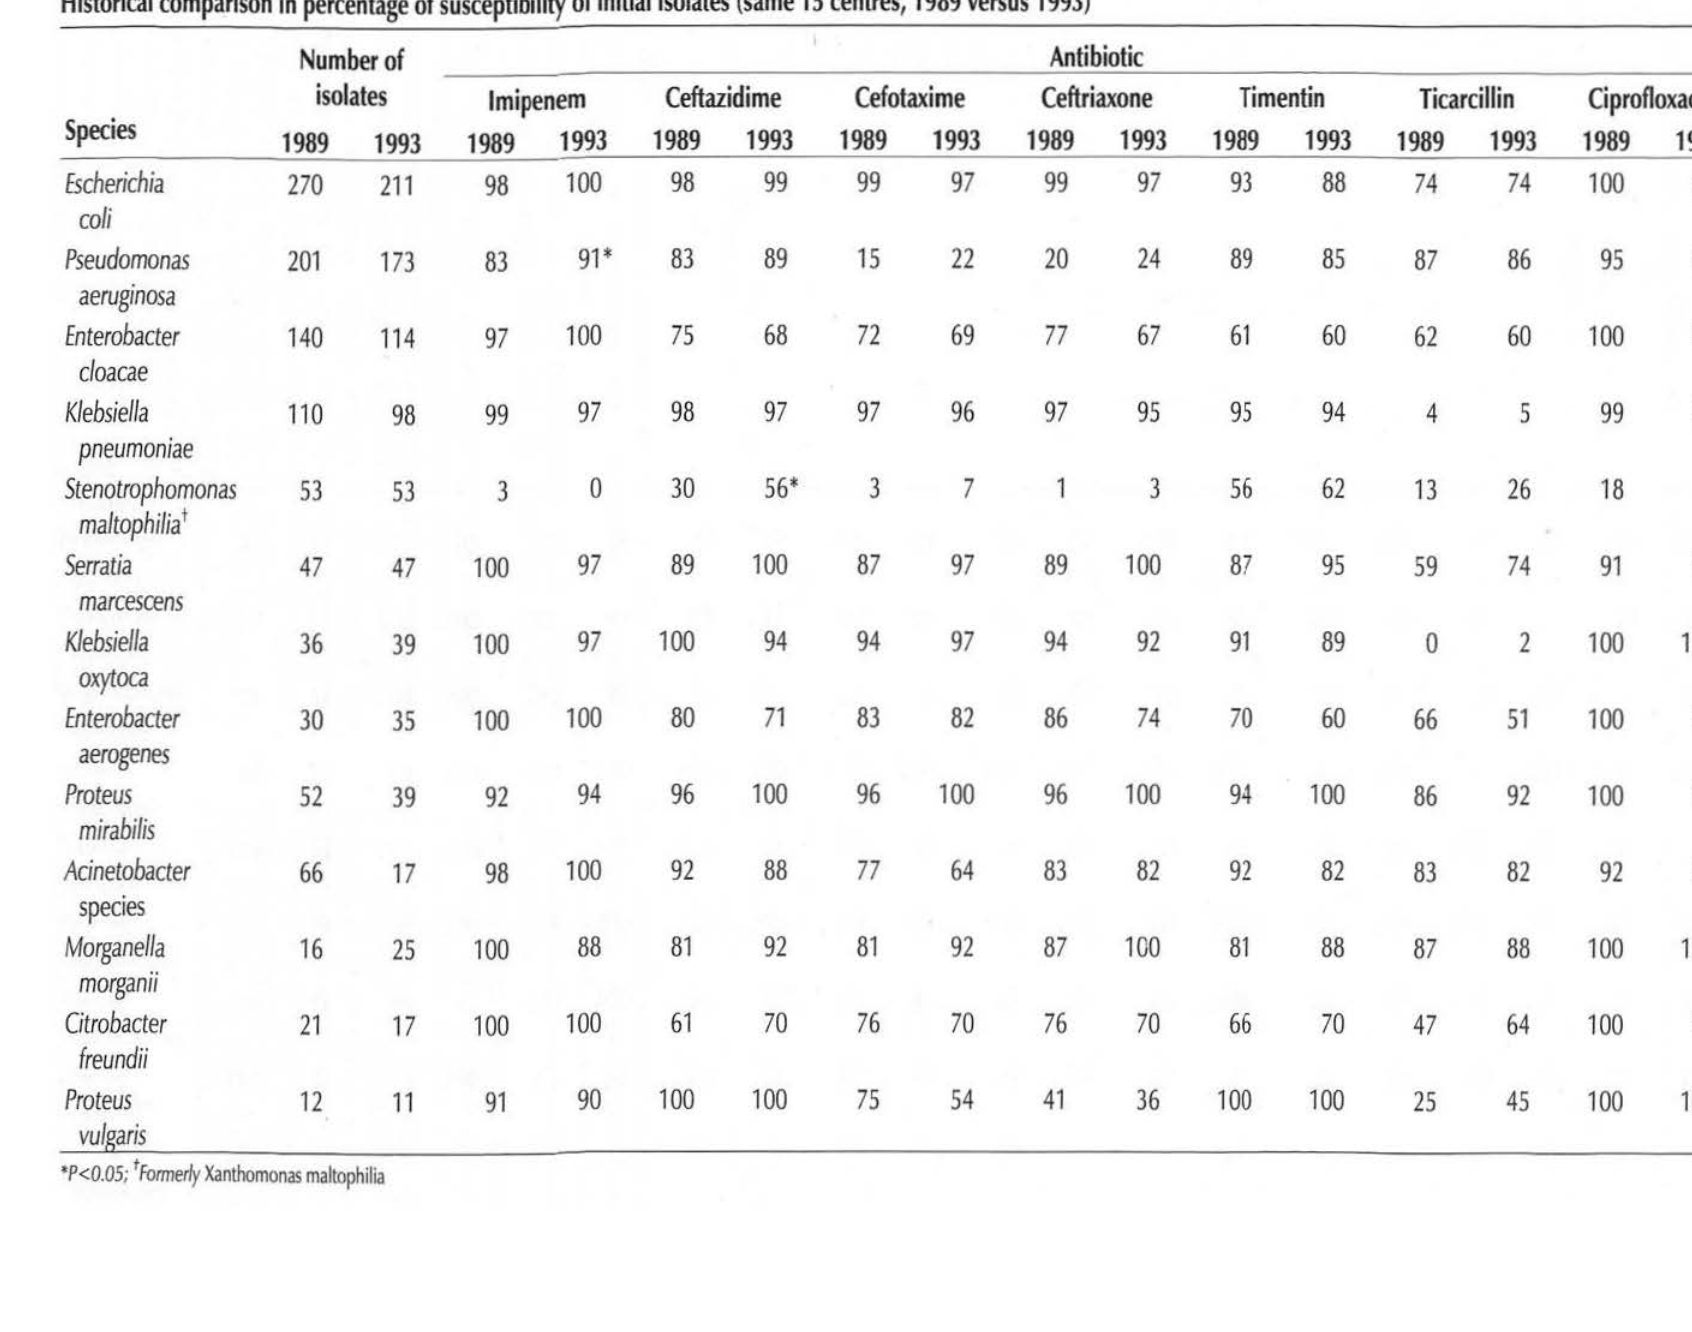
Historical comparison in percentage of susceptibility of initial isolates (same 15 centres, 1989 versus